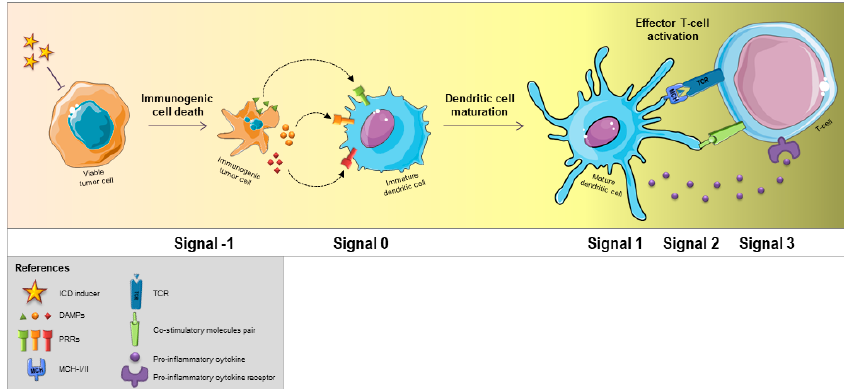
Figure 1. Sequential events required for a proper T-cell mediated antitumor immune response initiated by dying cells. The recently proposed “signal − 1” consists of the induction of immunogenic cell death (ICD) on tumor cells. ICD causes the release or surface exposure of a series of damage-associated molecular patterns (DAMPs) through a well-defined spatiotemporally scheme, which activate pattern recognition receptors (PRRs) in immature dendritic cells (DCs), a process that is referred to as “signal 0”. Next, “signal 1” involves the antigen-recognition event that is mediated by the binding of T cell receptor (TCR) to MHC-peptide complexes on the DCs surface. Co-stimulatory signaling is the so-called “signal 2”, whereas “signal 3” is the polarizing and di ff erentiation signal delivered by DCs to T cells, which directly influences their di ff erentiation into antitumor e ff ector cells. Figure created using Servier Medical Art images (http: //